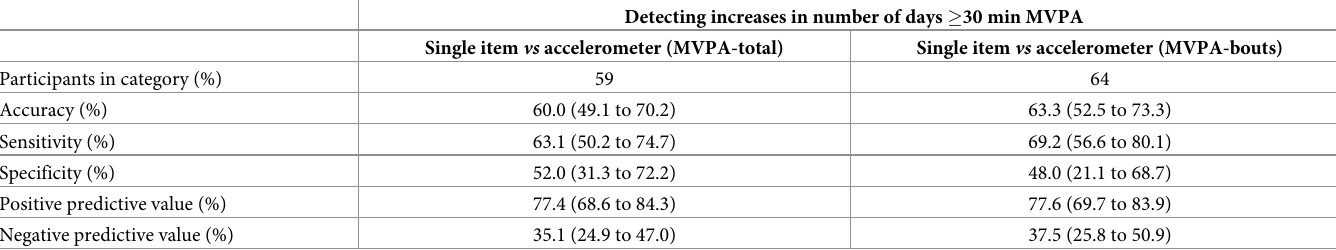
Table 2. Binary classification tests for the single item measure versus accelerometer total MVPA (MVPA-total) and MVPA occurring in bouts (MVPA-bouts) for detecting increases in number of days � 30 minutes MVPA from week one to week two. Detecting increases in number of days � 30 min